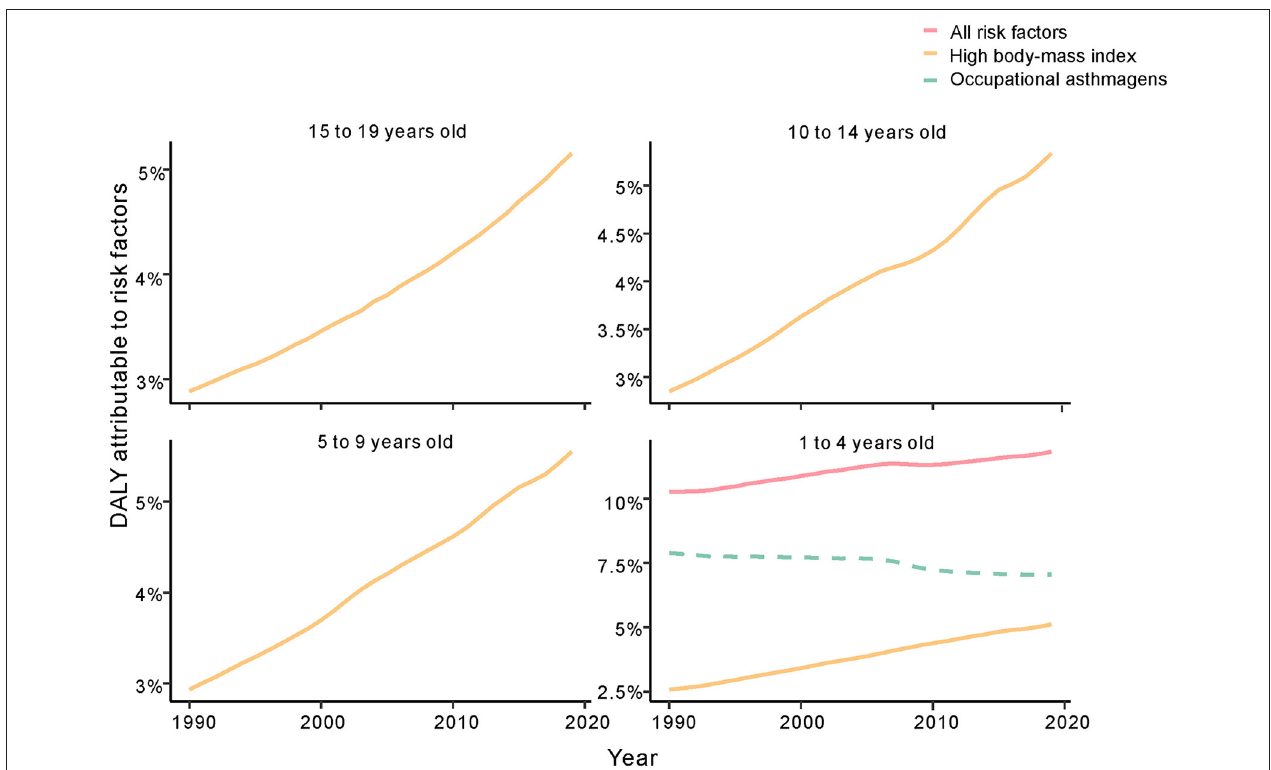
FIGURE 6 | Fraction of age-standardized DALYs attributable to high BMI and occupational asthmagens in childhood asthma by SDI region, 1990–2019. DALYs, disability adjusted life years; SDI, sociodemographic index; BMI, high body mass index.